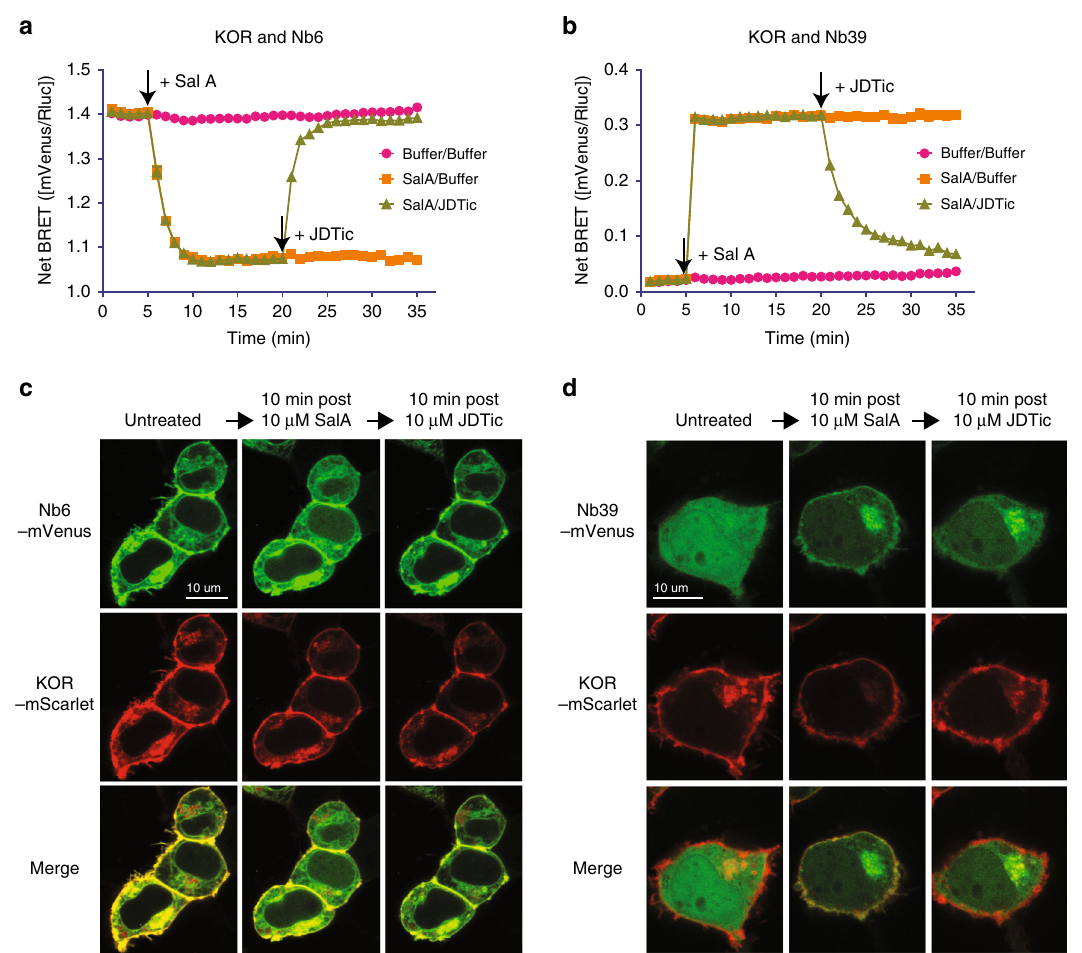
Fig. 4 Nb6 and Nb39 as biosensors probe KOR conformation in real-time. a , b Association and dissociation kinetics of KOR – Nb6 ( a ) or KOR – Nb39 ( b ). The experiments were conducted using BRET-based assays and data were analyzed by GraphPad Prism. 10 µ M agonist Sal A or antagonist JDTic was added at indicated time points by black arrows. ( N = 5, fi ve experiments each done in duplicate) c Confocal live-cell imaging of HEK 293T cells expressing KOR-mScarlet and Nb6-mVenus. 10 µ M Sal A or JDTic was added to the cell plate at indicated time points. ( N = 3, three experiments each done in duplicate) d Confocal live-cell imaging of HEK 293T cells expressing KOR-mScarlet and Nb39-mVenus. 10 µ M Sal A or JDTic was added at indicated time points. Error bars represent SEM. ( N = 3, three experiments each done in duplicate). Source data are provided as a Source Data fi